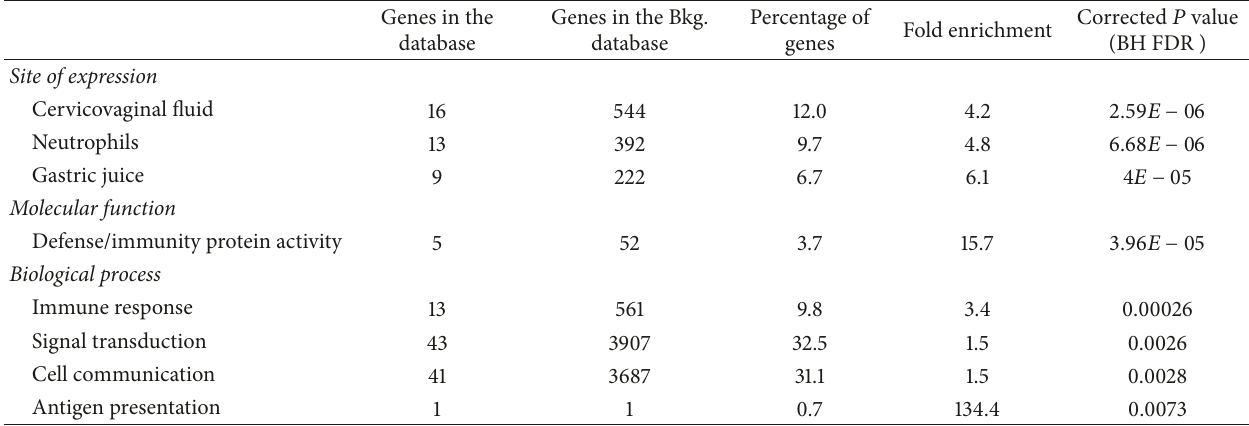
Table 8: Functional enrichment analysis of control EV proteins. Genes in the Genes in the database